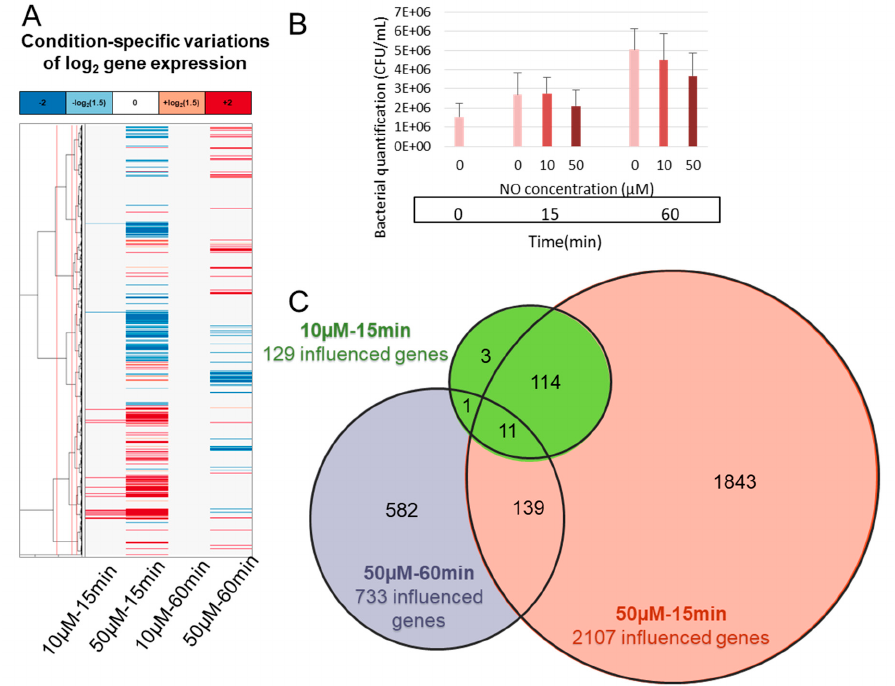
Figure 1. RNA sequencing on Bacillus cereus after nitric oxide stress. Bacteria were exposed to NO stress (10 µ M or 50 µ M) for 15 or 60 min. mRNA was extracted and sequenced by NextSeq. ( A ) Differentially expressed genes profiles based on reads mapped on reference genome of Bc407 (NC_018877.1) aggregated at gene level shows the overexpressed (in red) or under expressed (in blue) genes. Genes are clustered in co-expression groups; ( B ) bar chart representing the bacterial load for each condition; ( C ) Venn diagram showing the size and overlap of the sets of genes up- or down-regulated in each condition (empty set for the condition 10 µM-60 min).